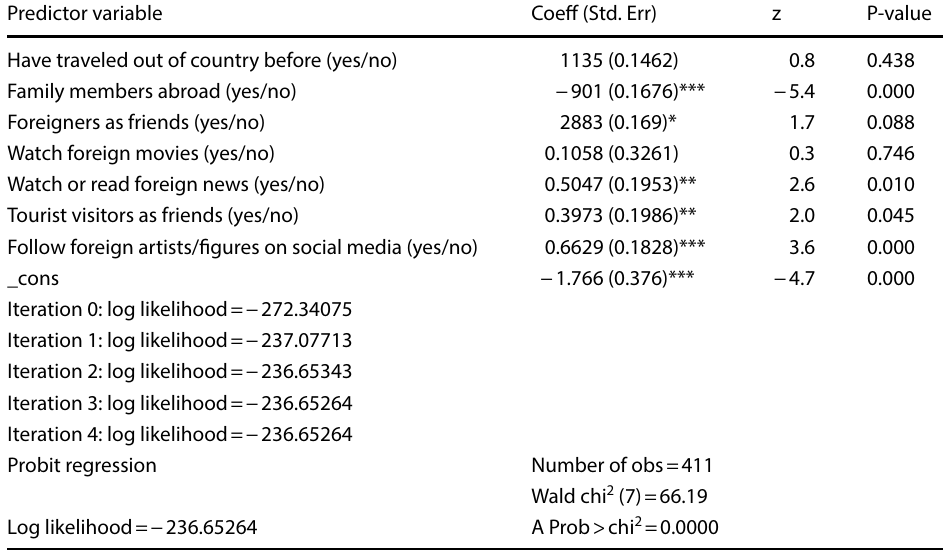
Table 2 Showing independent variables that are predictors of remote